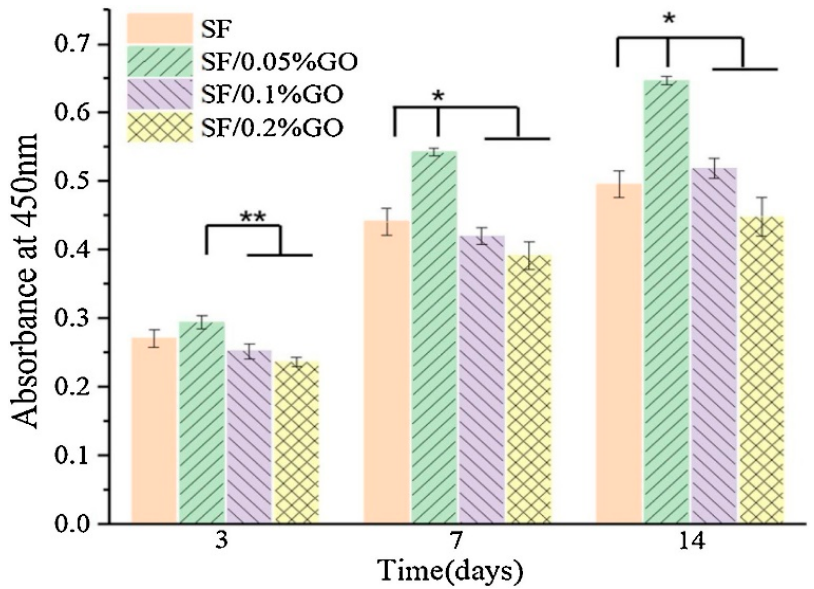
Figure 5. MSCs proliferation using SF/GO composites in different ratios, i.e., SF/0.05%GO, SF/0.1%GO, and SF/0.2% GO. Proliferation rate was indirectly estimated by the absorbance as a function of time (** p < 0.05, * p < 0.01) [98].